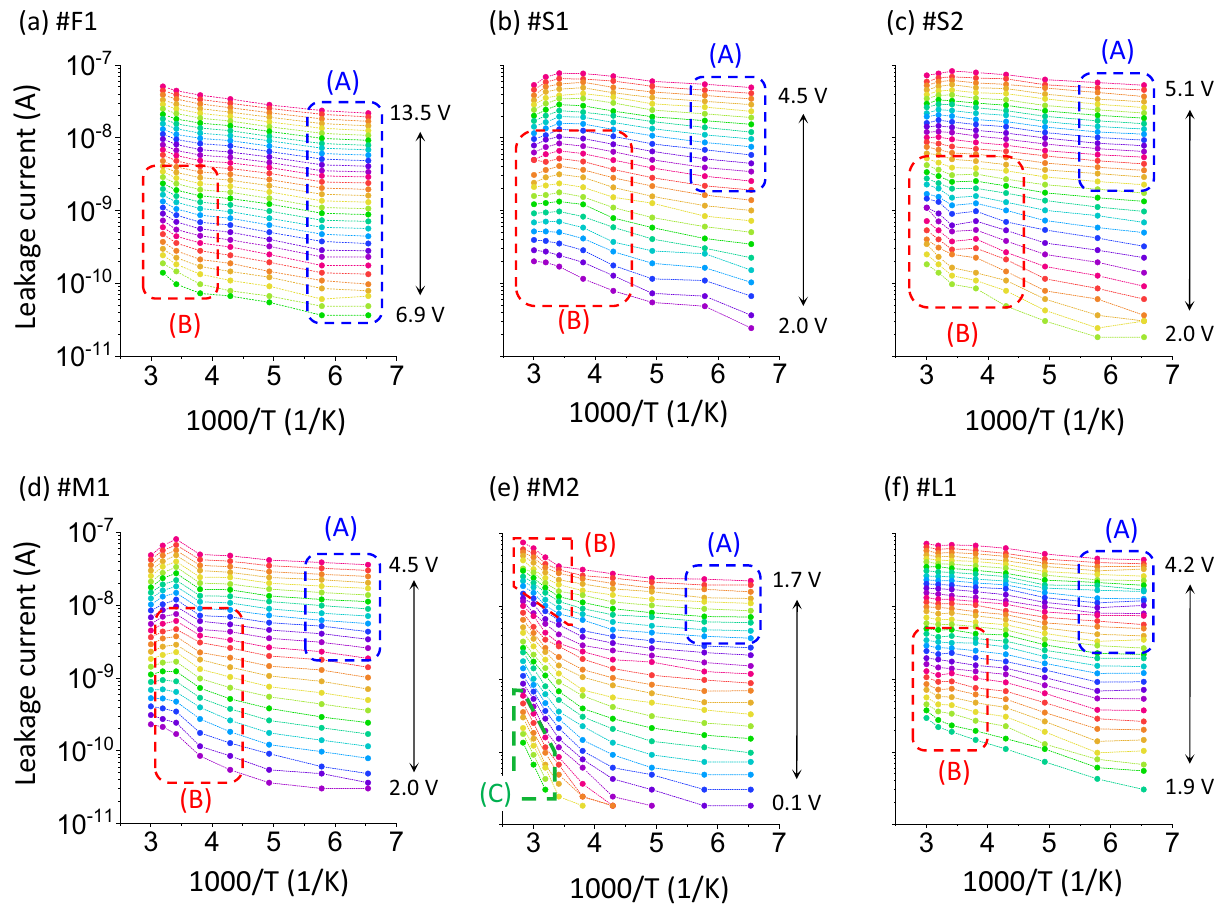
Figure 6. I vs. 1000/ T data acquired under reverse bias conditions at different voltages for the ( a ) #F1, ( b ) #S1, ( c ) #S2, ( d ) #M1, ( e ) #M2 and ( f ) #L1